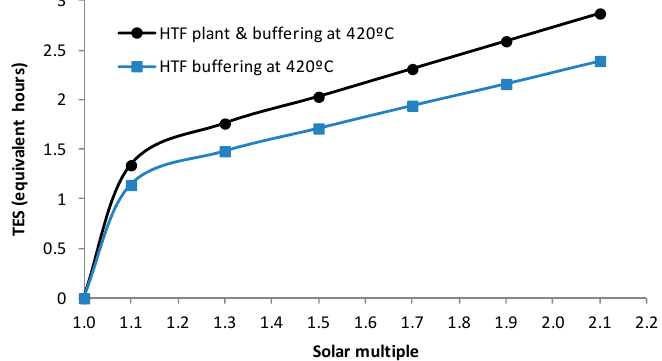
Figure 8. Averaged annual HTF buffering TES as a solar multiple function.